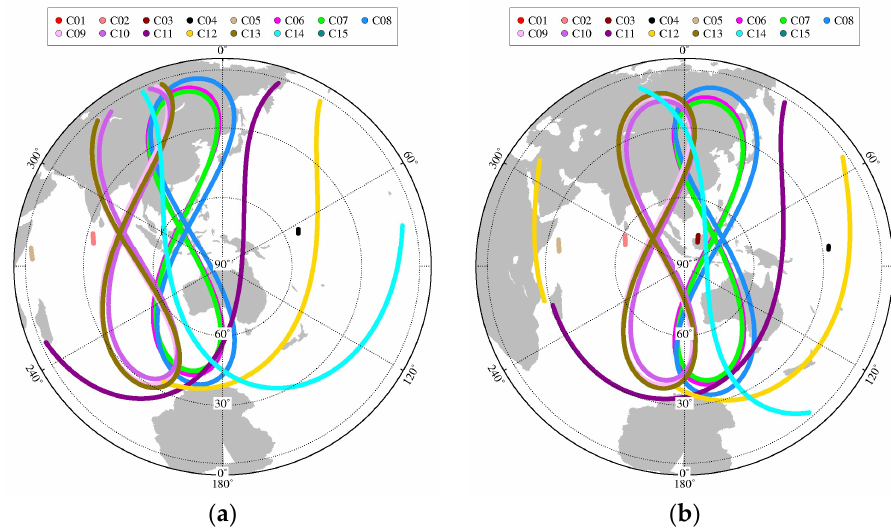
Figure 17. The skyplot of station: ( a ) KAT1; ( b ) XMIS.